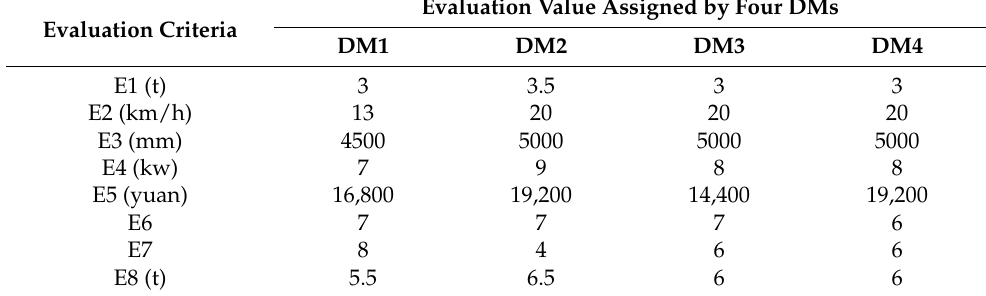
Table A6. Initial evaluation matrix of the electric forklift PSS concept (taking the CS5 as an example). (a) Scheme Value Assessment of Evaluation Criteria on the PSS Design Evaluation Criteria